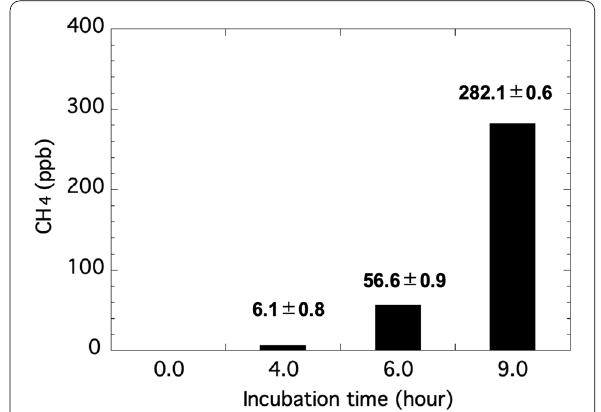
Fig. 7 The time profiles of CH 4 concentration in head space by a short‑term culture experiment. The data showed the average value of the measurement of CH 4 in the gas phase within the incubation time ( t 0, 4, 6, 9 h; t 0 as initial concentration) = =